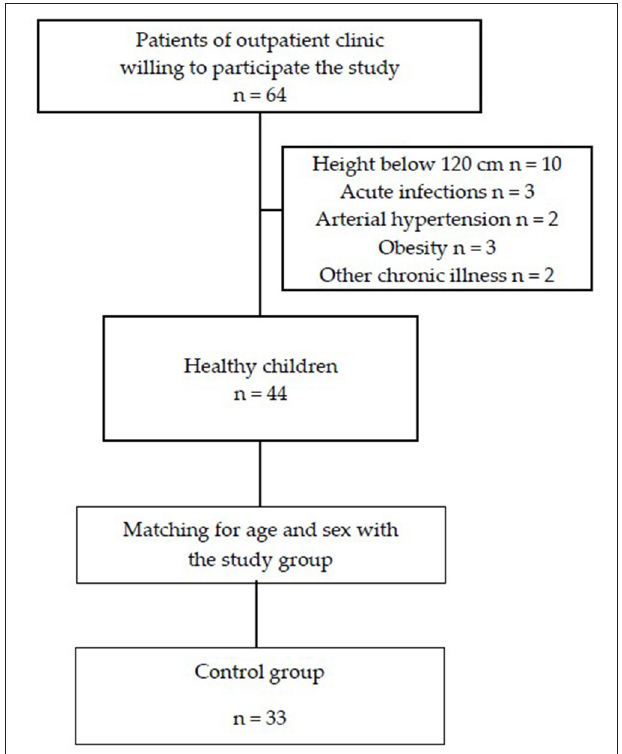
FIGURE 2 | Flowchart of the control group